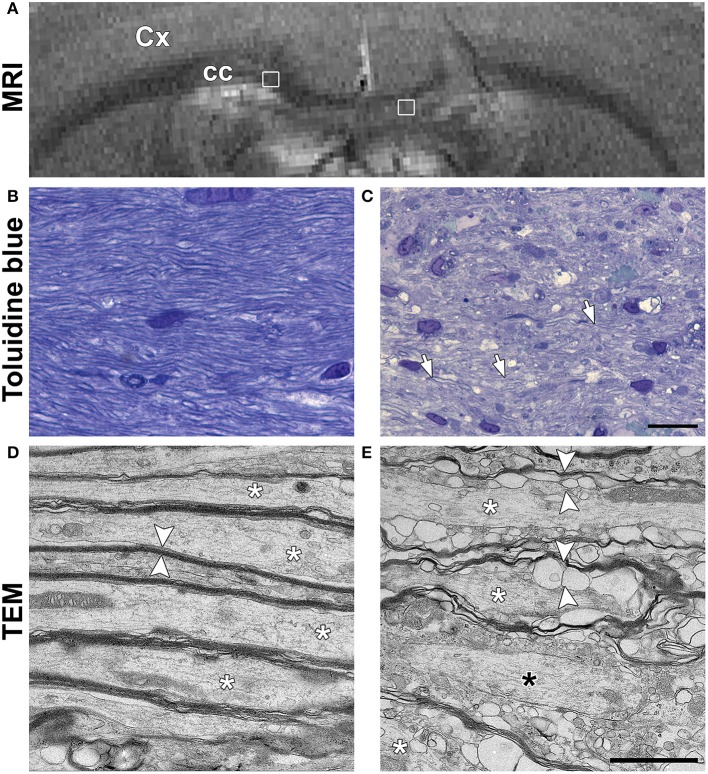
(A)
In vivo T2-weighted image of a rat used for the ultrastructural analysis using transmission electron microscopy (TEM). White squares indicate the location of the images shown in (B,C). Representative photomicrographs of Toluidine blue stained sections of the normal corpus callosum (B) and demyelinating lesion (C). White arrows in panel C point at axons with thin myelin sheath. Scale bar in (B,C) is 20 μm. Representative photomicrographs obtained in TEM are shown for the normal corpus callosum (D) and demyelinated lesion (E). White asterisks indicate individual axons in both (D,E). In (D), axons have normal and packed myelin sheaths (white arrowheads). In (E), the myelin sheaths appear loosely packed and full of pockets (white arrowheads). A black asterisk indicates an axon without myelin sheath. Scale bar in (D,E) is 200 nm.